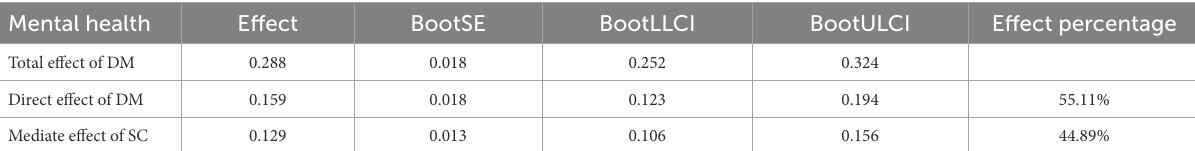
TABLE 4 Mediation effect of self-compassion.